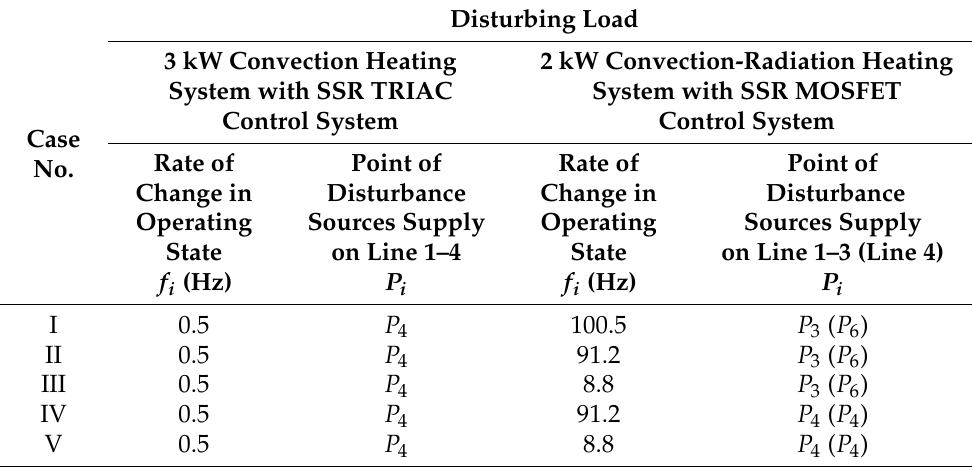
Table 5. Selected cases for verification of the proposed algorithm for selective identification and localization of voltage fluctuation